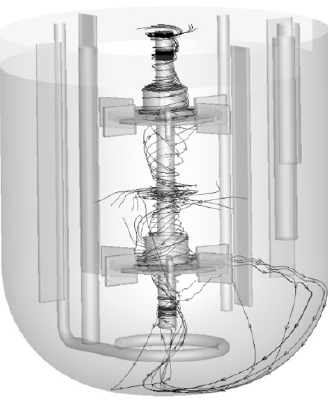
Figure A16. Visualization of the instantaneous precessional vortices around the axis of Xanthan Sol C, after the simulation of 58 impeller turns.